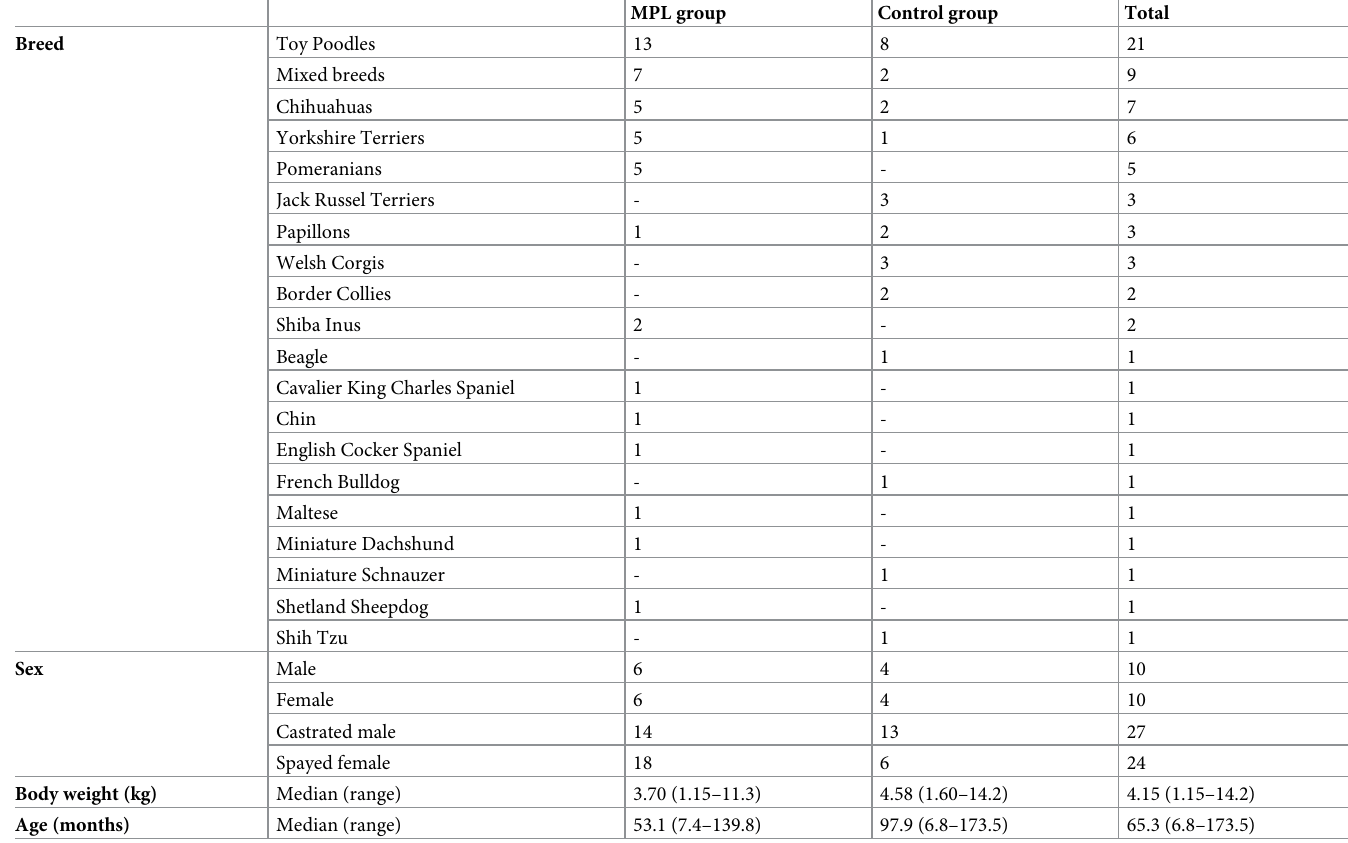
Table 1. The breed, sex, median body weight (range), and median age (range) of the dogs in the medial patellar luxation (MPL) and control groups.